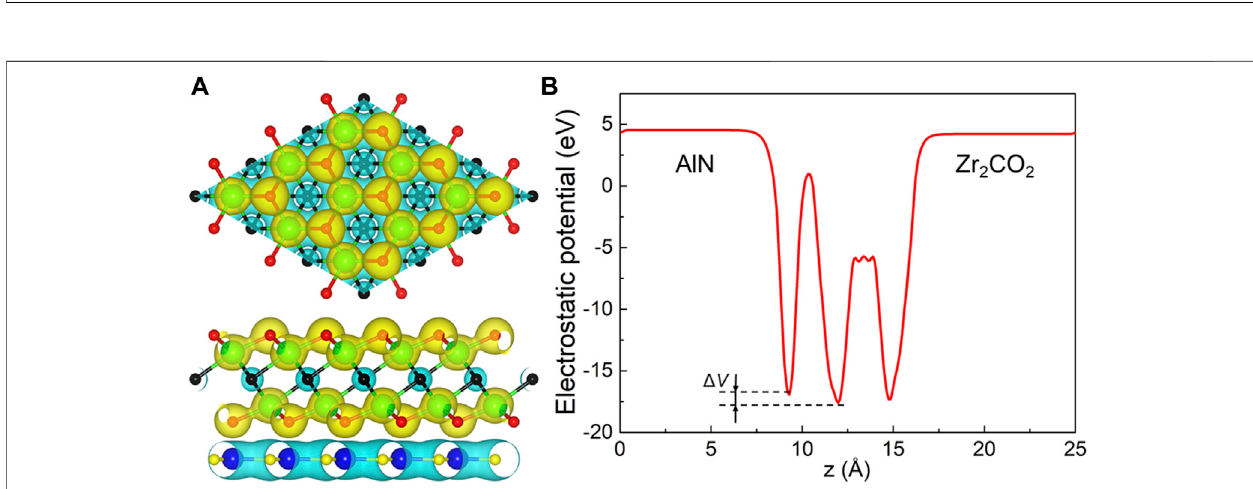
FIGURE4|(A) Thechargedensitydifferenceandthe (B) potentialdropoftheAlN/Zr 2 CO 2 vdWheterostructure.Theyellowandcyanregionscontributethegaining and losing of electrons, respectively.